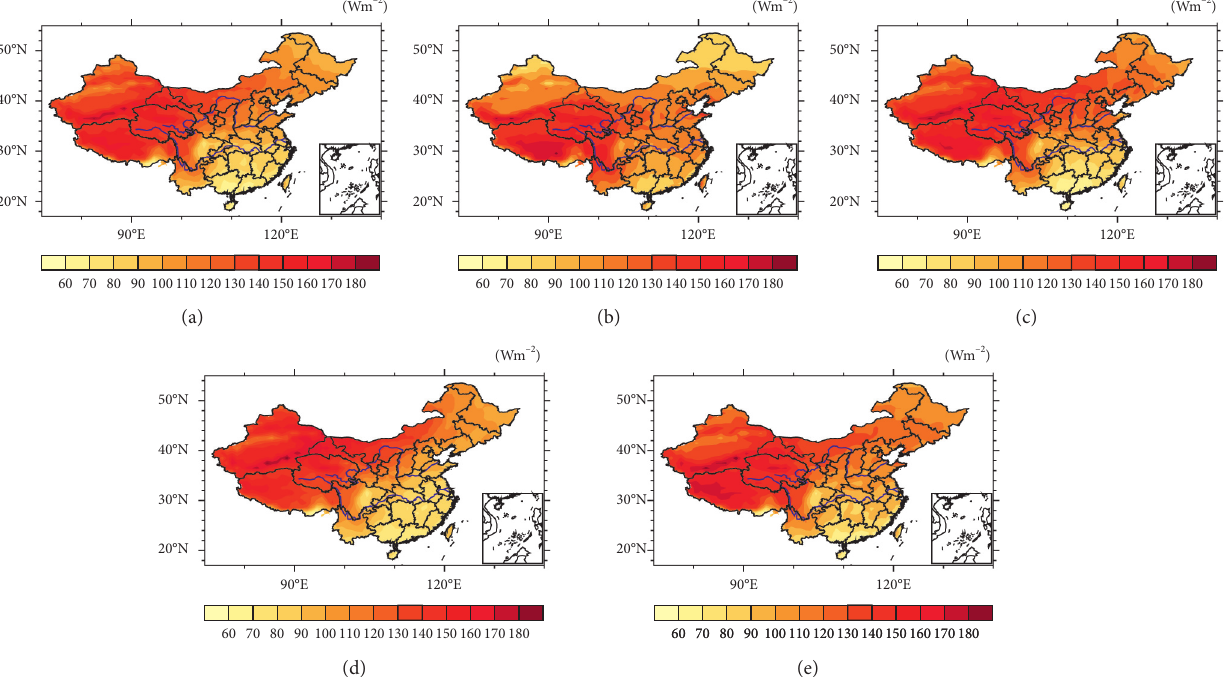
Figure 2: Distribution of annual and seasonal LER mean (unit: Wm − 2 ) in China under clear-sky conditions during the period 2001–2016: (a) annual, (b) spring, (c) summer, (d) autumn, and (e)